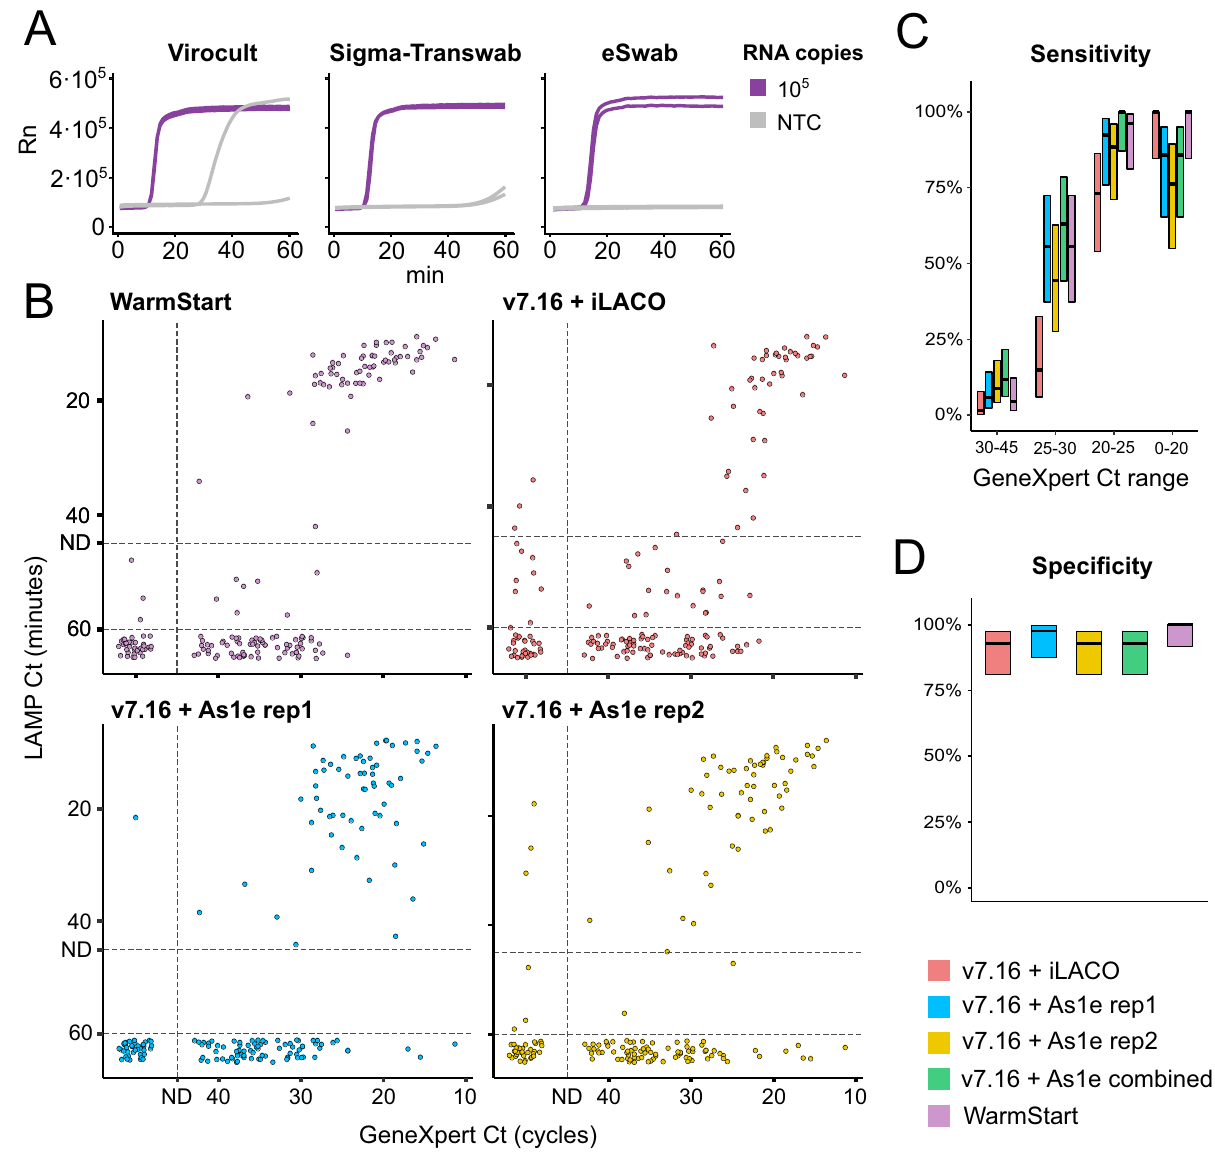
Figure 4. Applicability of RT-LAMP to unextracted nasopharyngeal samples. ( A ) Effect of common virus transport media on RT-LAMP amplification with v7.16 and MashUp-RT (same conditions and same experiment as in Fig. 2B). Different transport media were added at 10% of the reaction volume. ( B ) Comparisons of RT-LAMP Ct (minutes) and GeneXpert RT-qPCR Ct (cycles) for 184 clinical samples. The developed v7.16 + RT-MashUP reaction mix was tested with iLACO (red) or As1e primer sets (blue/yellow). As1e primer set was also tested with commercial WarmStart Colorimetric master mix (violet). ND designates the thresholds for calling positives (see methods). ( C ) Reaction sensitivity according to SARS-CoV-2 abundance as determined by GeneXpert. When technical replicates of As1e were performed and considered together, sensitivity improved (in green, positives were called when at least one replicate was identified as positive). Number of samples in each Ct range: Ct 0–20 = 21, Ct 20–25 = 26, Ct 25–30 = 27, Ct 30–45 = 68. Wilson’s binomial confidence intervals of 95% are shown 17 . ( D) Reaction specificity, as % of samples considered negatives by RT-qPCR that were also negative by RT-LAMP. Wilson’s binomial confidence intervals of 95% are